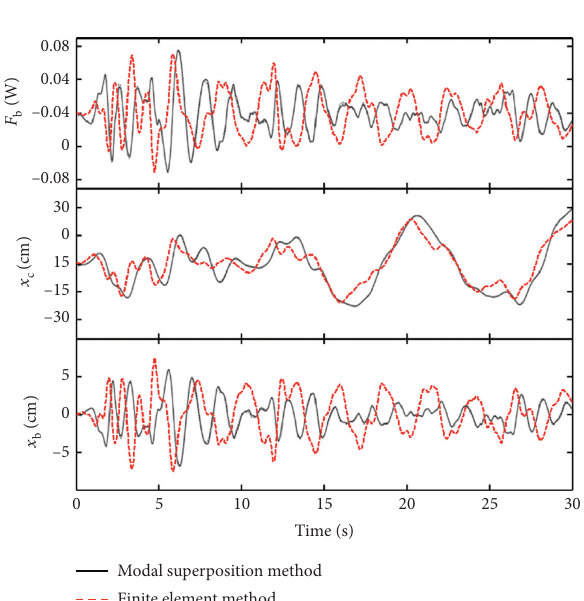
Figure 3: Comparison of the computed time-history response for broad tank [2] through the finite element method and modal superposition